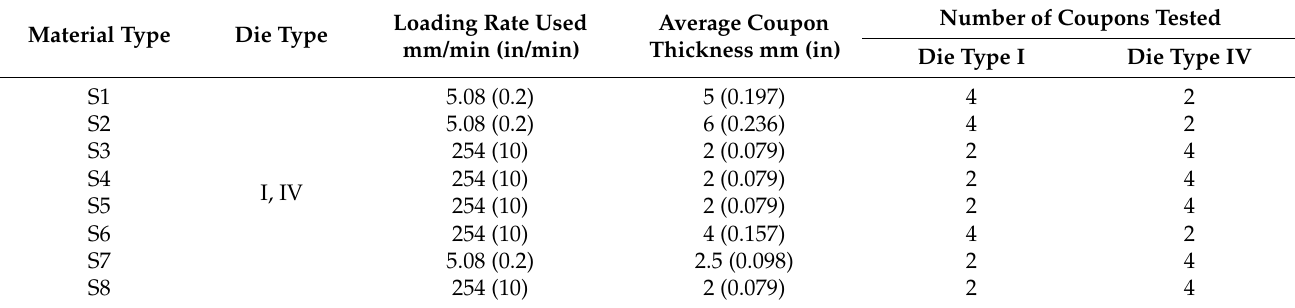
Table 2. Test matrix, loading rates used, polyurea coupon thickness, and number of coupons tested.